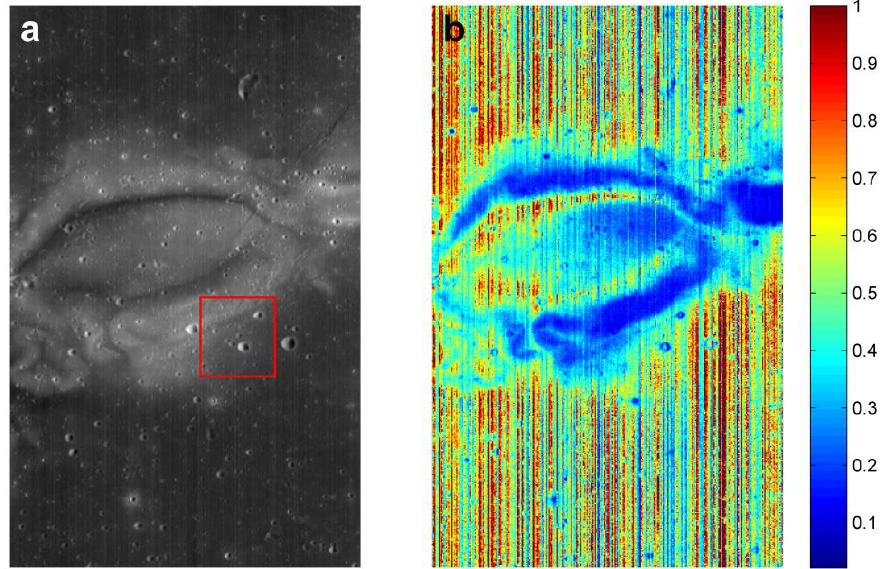
Figure 14. ( a ) M 3 750 nm reflectance image for lunar swirl ‘Reiner Gamma’; ( b ) npFe 0 abundance distribution of ‘Reiner Gamma’.